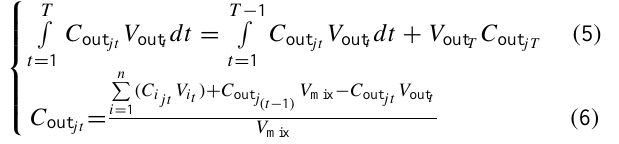
potential end members i , respectively; Q tot and Q i corre- spond to the total discharge at the mixing point and the pro- portional contribution of the tracer i and ε j , which ideally tends to zero, corresponds to the accumulation of inaccura- cies, uncertainties, errors, and approximations that can occur during the sampling, handling, and analysis for the tracer j